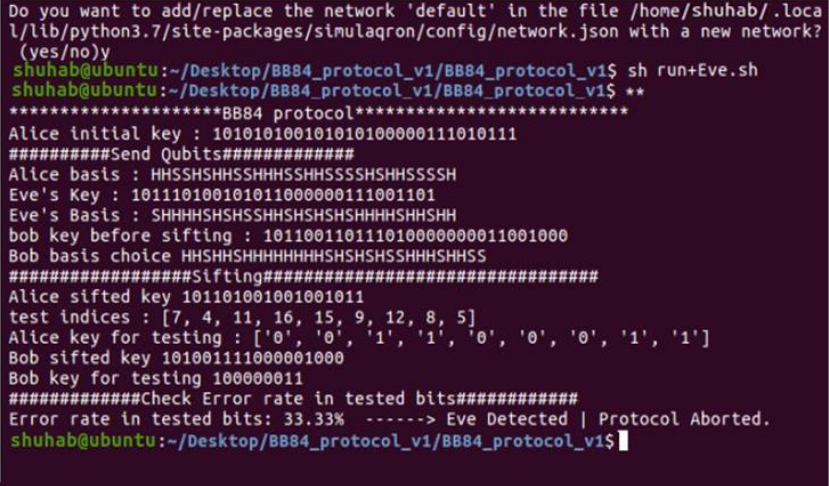
Figure 6. Testing of error rate in presence of Eve.